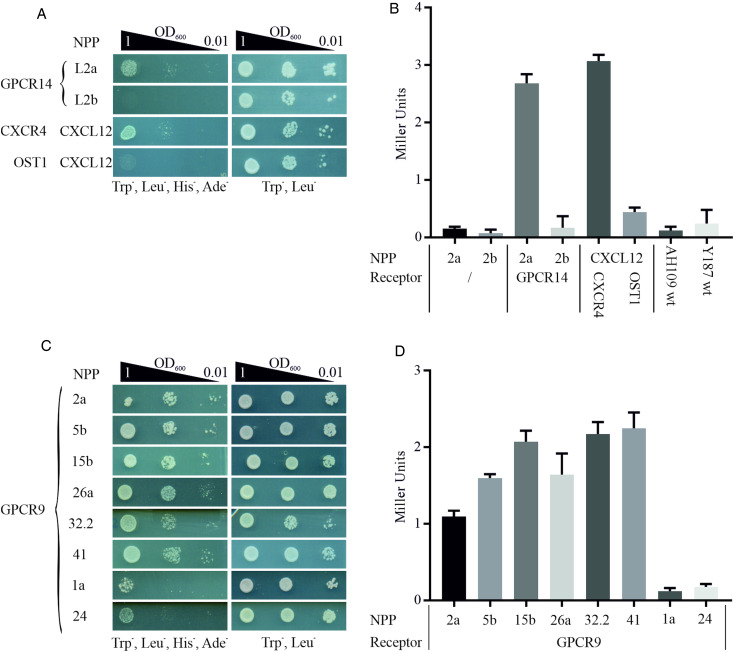
Detection of protein–protein interactions between GPCRs and hormone peptides. Shown are cell growth assays of yeast strain AH109 transfected with plasmids expressing ligand fusion proteins (NPP), which was mated with yeast strain Y187 transfected with plasmids expressing (A) Smp_203500 (GPCR14) and (C) Smp_244240opt (GPCR9), respectively. The classic chemokine CXCL12 and its known receptor CXCR4 were employed as a positive control (Li et al., 2016). OST1 is a transmembrane protein of S. cerevisiae and in combination with CXCL12 used as the negative control. Three different OD600 concentrations of diploid yeast cells were dropped onto SD/Trp− Leu− His− Ade− and Trp− Leu− plates; the latter served as growth control. Colony growth was monitored after 72 and 48 h, respectively. (B, D) ONPG-assays to measure β-Gal activity of diploid cells as in A and C. Cells were lysed in liquid nitrogen and incubated with ONPG for ~30 min at 30°C. OD405 was measured, and Miller Units were calculated (Miller Units = 1000 × OD405/t(min) × OD600). Shown are the mean values of two clones (n = 2).